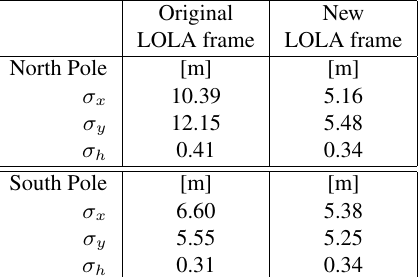
Figure 2. The LOLA DTMs have a resolution of ten meter per pixel, span 200 by 200 km and are displayed in polar stereographic projection. (a) North pole. (b) South pole.